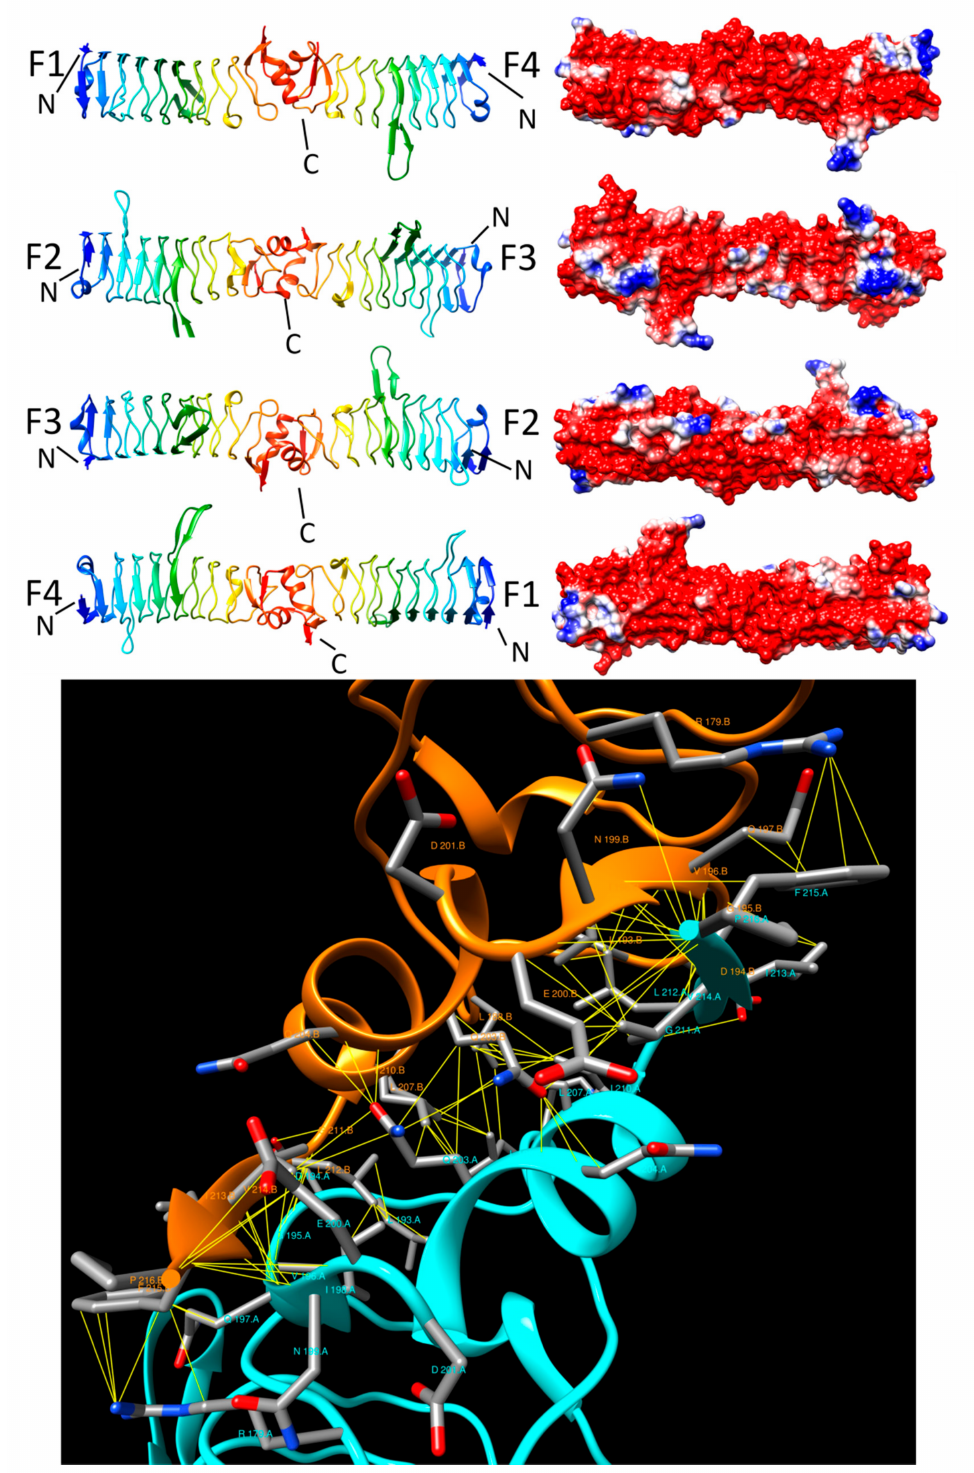
Figure 7. Structure and analysis of AhQnr. The top panel shows the ribbon diagrams of the structure for four different orientations (at left) and the corresponding electronic potential surface plots (at right). The bottom panel is the interface model calculated by Intersurf and depicted using